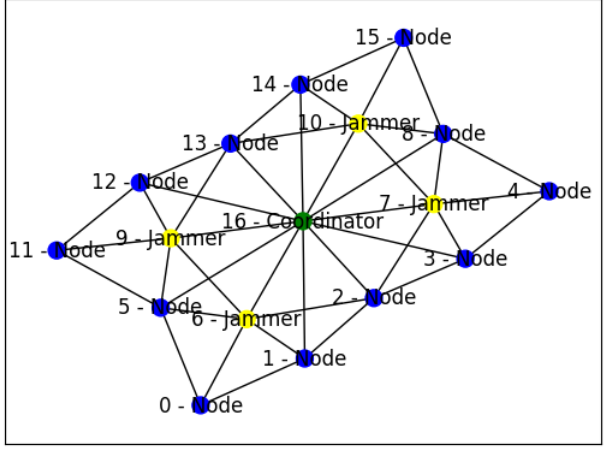
Figure 22. Network simulated.